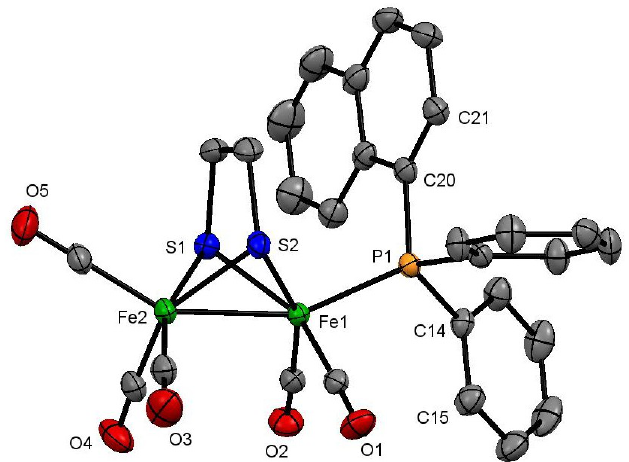
Figure 1. Molecular structure of [Fe 2 (CO) 5 {κ 1 -PPh 2 (1-C 10 H 7 )}(μ-edt)] ( 2 ) showing 50% probability thermal ellipsoids. Hydrogen atoms are omitted for clarity. [Selected bond distances (Å) and angles (°): Fe(1)–Fe(2) 2.5036(4), Fe(1)–P(1) 2.2442(6), Fe(1)–S(1) 2.2501(6), Fe(1)–S(2) 2.2611(6), Fe(2)–S(1) 2.2520(6), Fe(2)–S(2) 2.2470(6); P(1)–Fe(1)–Fe(2) 155.755(18), P(1)–Fe(1)–S(1) 107.76(2), P(1)–Fe(1)–S(2)